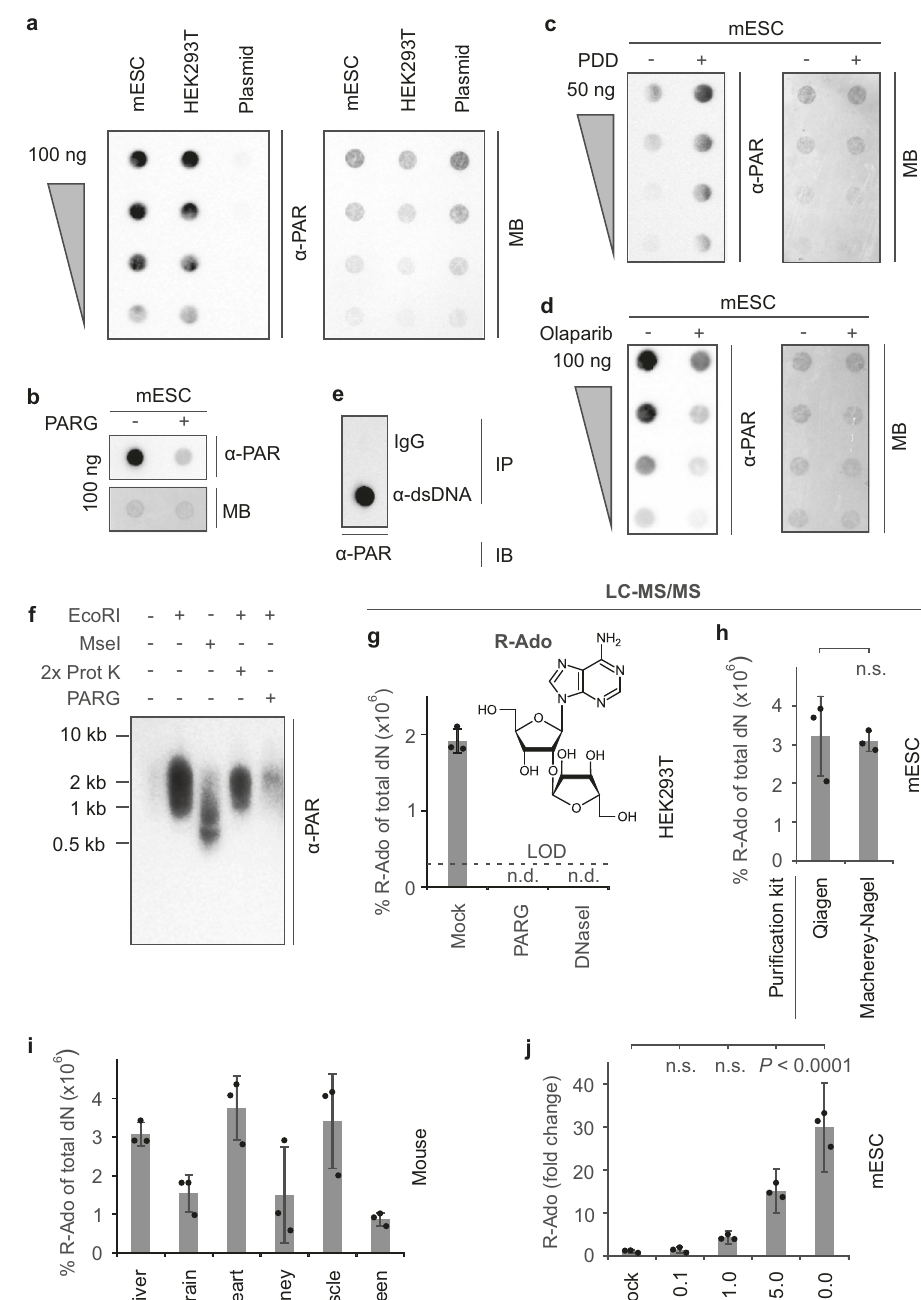
Fig. 1 | Mouse and human genomic DNA is PARylated. Dot blot analysis for PARylationof mESC,HEK293Tandplasmid DNA( a ),mESCDNAtreatedwithPARG ( b ), DNA puri fi ed from mESCs treated with the PARG inhibitor PDD00017273 ( c ), DNA puri fi ed from mESCs treated with the PARP inhibitor olaparib ( d ), genomic mESC DNA after IP with IgG or anti-dsDNA antibody ( e ). gDNA was serially diluted (2×) in a and c , d ; MB, methylene blue. f Southwestern blot analysis for PARylation ofmESCDNAtreatedwithEcoRI,MseI,ProteinaseK,andPARGasindicated.Length of marker DNA is shown on the left. Southwestern is representative of three inde- pendentexperimentswithsimilaroutcomes. g LC-MS/MSquanti fi cationofribosyl- adenosine (R-Ado) onHEK293TDNAtreated asindicated.Samples wererepuri fi ed after enzyme treatments by a second column-based DNA puri fi cation to remove any PAR and DNA monomers. Dashed line, limit of detection (LOD). Data are